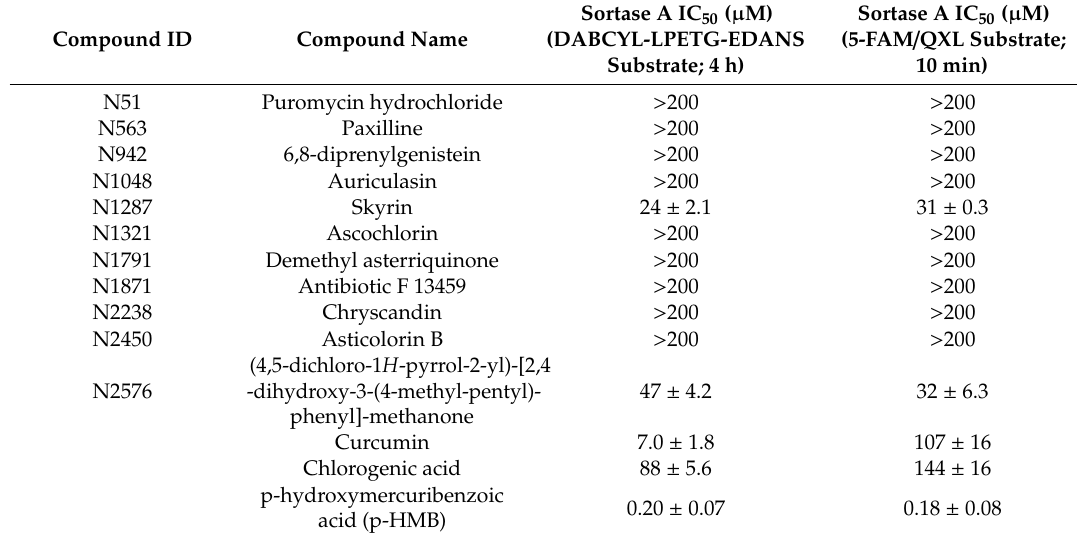
Table 2. Mean sortase A IC 50 values of eleven in silico hits, two reported natural inhibitors (curcumin and chlorogenic acid), and a synthetic inhibitor p-hydroxymercuribenzoic acid. IC 50 denotes the half maximal inhibitory concentration of the compound, as determined from GraphPad Prism